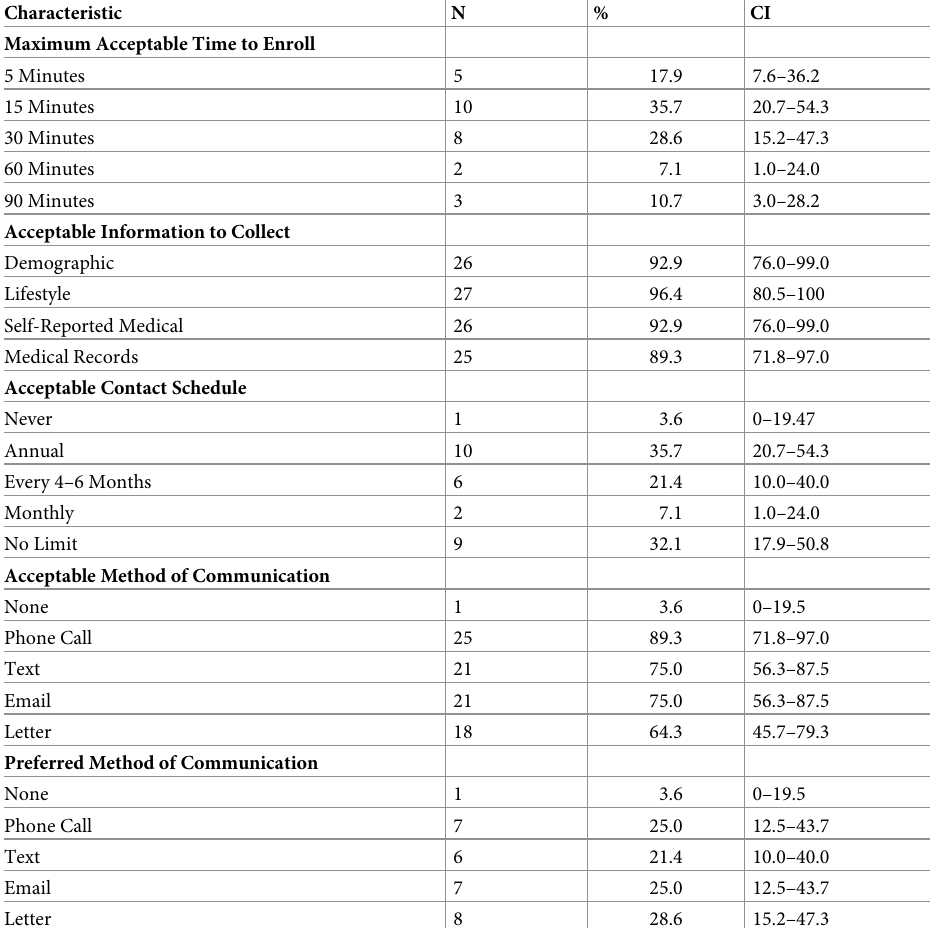
Table 2. Parental preferences for enrollment logistics and